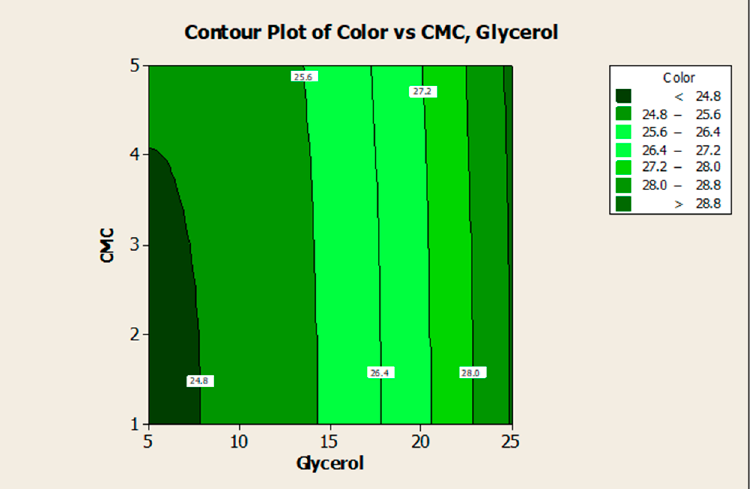
Figure 2. Contour plot for the effect of glycerol and CMC concentration on the color lightness of mangosteen-leaves-based marker ink.